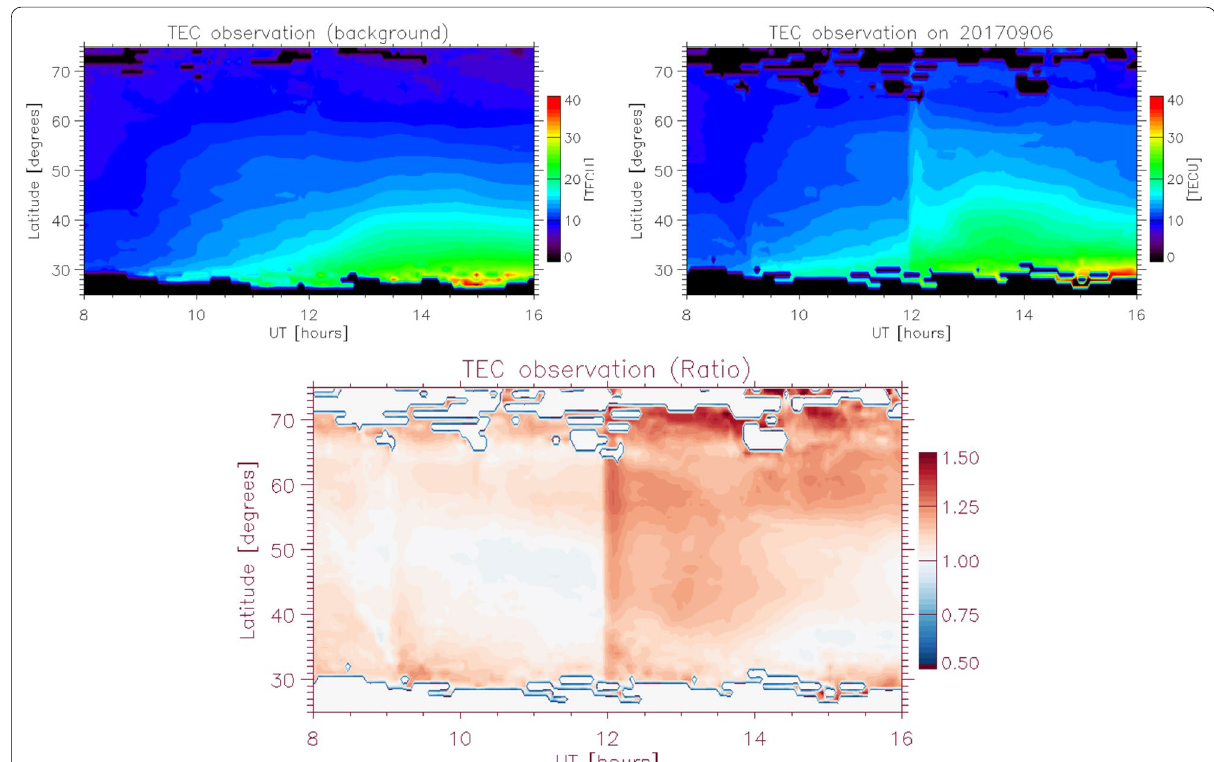
Fig. 4 TEC observations at 0°E 25–75°N. (Top left) Averaged TEC from September 1 to 10, 2017. This is the background. (Top right) TEC on September 6, 2017. (Bottom) Ratio of TEC from flare (top-right figure) and the background (top-left figure). TEC significantly increases at any latitude when flare